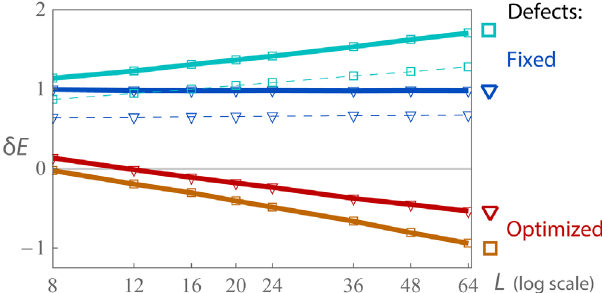
FIG. 9. Energy cost for fixed and optimized monomers on the square and triangular lattices. Here we compare the energy cost for both fixed-site and partially optimized monomers between the square lattice (square symbols) and triangular lattice (triangle symbols), in a log-linear plot. For fixed defects, the growth of the standard deviation (dashed lines) ensures that optimized defects gain diverging energy, both for bipartite and nonbipartite lattices.